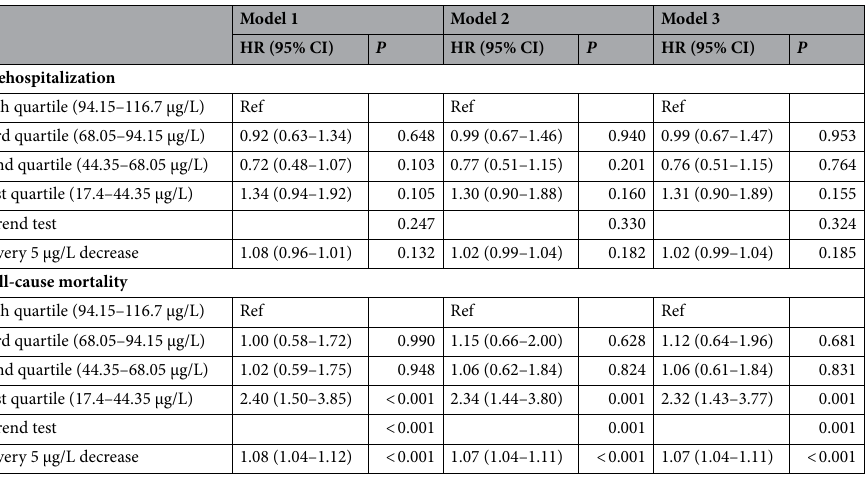
Table 3. The associations of serum selenium with prognosis in patients with heart failure. Data are completed for all variables. Model 1: no adjustment; Model 2: adjusted for age, sex, body mass index, smoking, drinking, hypertension, diabetes, chronic kidney disease, prior history of heart failure, and atrial fibrillation; Model 3: further adjusted for medication.